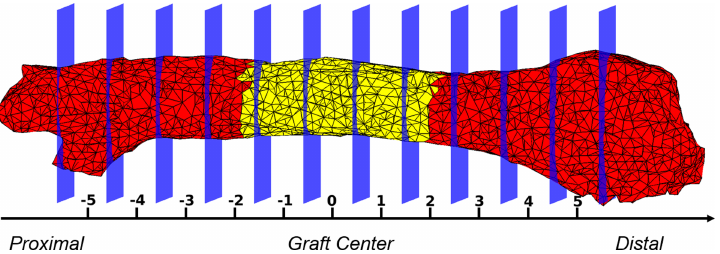
Fig 2. Segmentation of a femur into 1 mm segments to calculate the average of relative blood flow ( rBF ). Each femur segment was represented by its distance from the center of the graft, with negative values representing segments closer to the proximal end (connecting to the pelvis) and positive values closer to the distal end (connecting to the tibia). The yellow part in the center denotes the inserted graft, and the red parts are the parts of the host